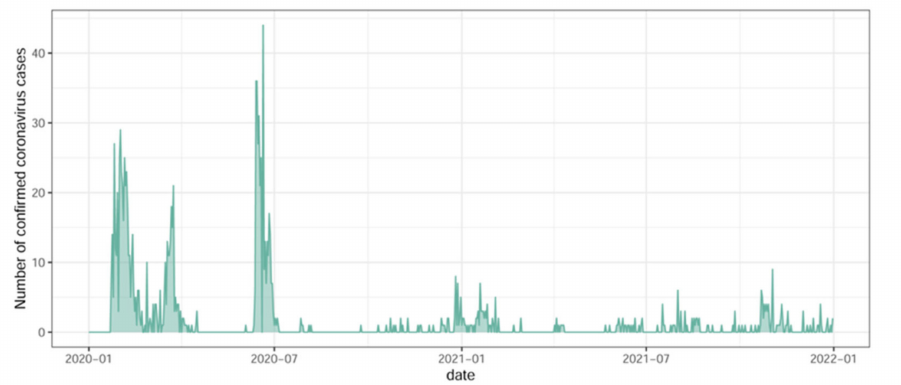
Figure 3. Number of confirmed COVID-19